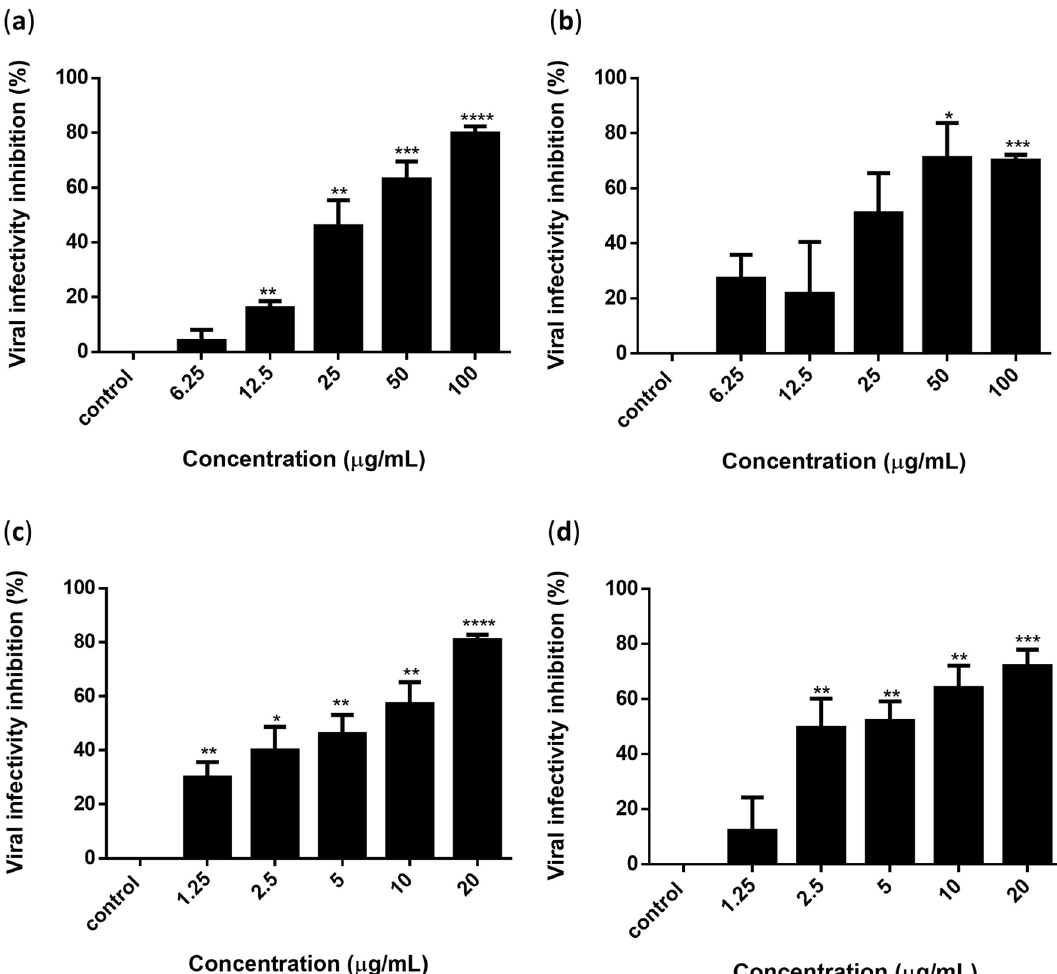
Figure 3. Baicalein and baicalin exhibited virucidal activity against DENV-3 progeny in a dose-dependent manner. Inhibition of viral progeny infectivity by baicalein was determined by ( a ) FFURA and ( b ) quantification of RNA copy number. Inhibition of viral progeny infectivity by baicalin was determined by ( c ) FFURA and ( d ) quantification of RNA copy number. Data presented as mean ± SEM. Error bars indicate the range of values obtained from three independent experiments. *P < 0.05, * *P < 0.01, * **P < 0.001, * ***P < 0.0001 indicates a significant difference compared to the negative control analyzed by the t